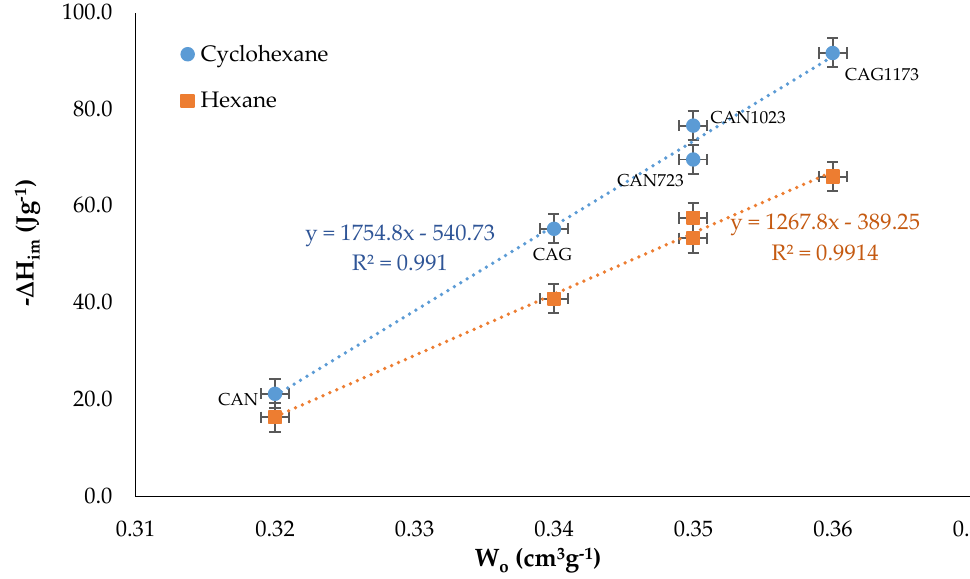
Figure 4. Immersion enthalpy as a function of the micropore volume.